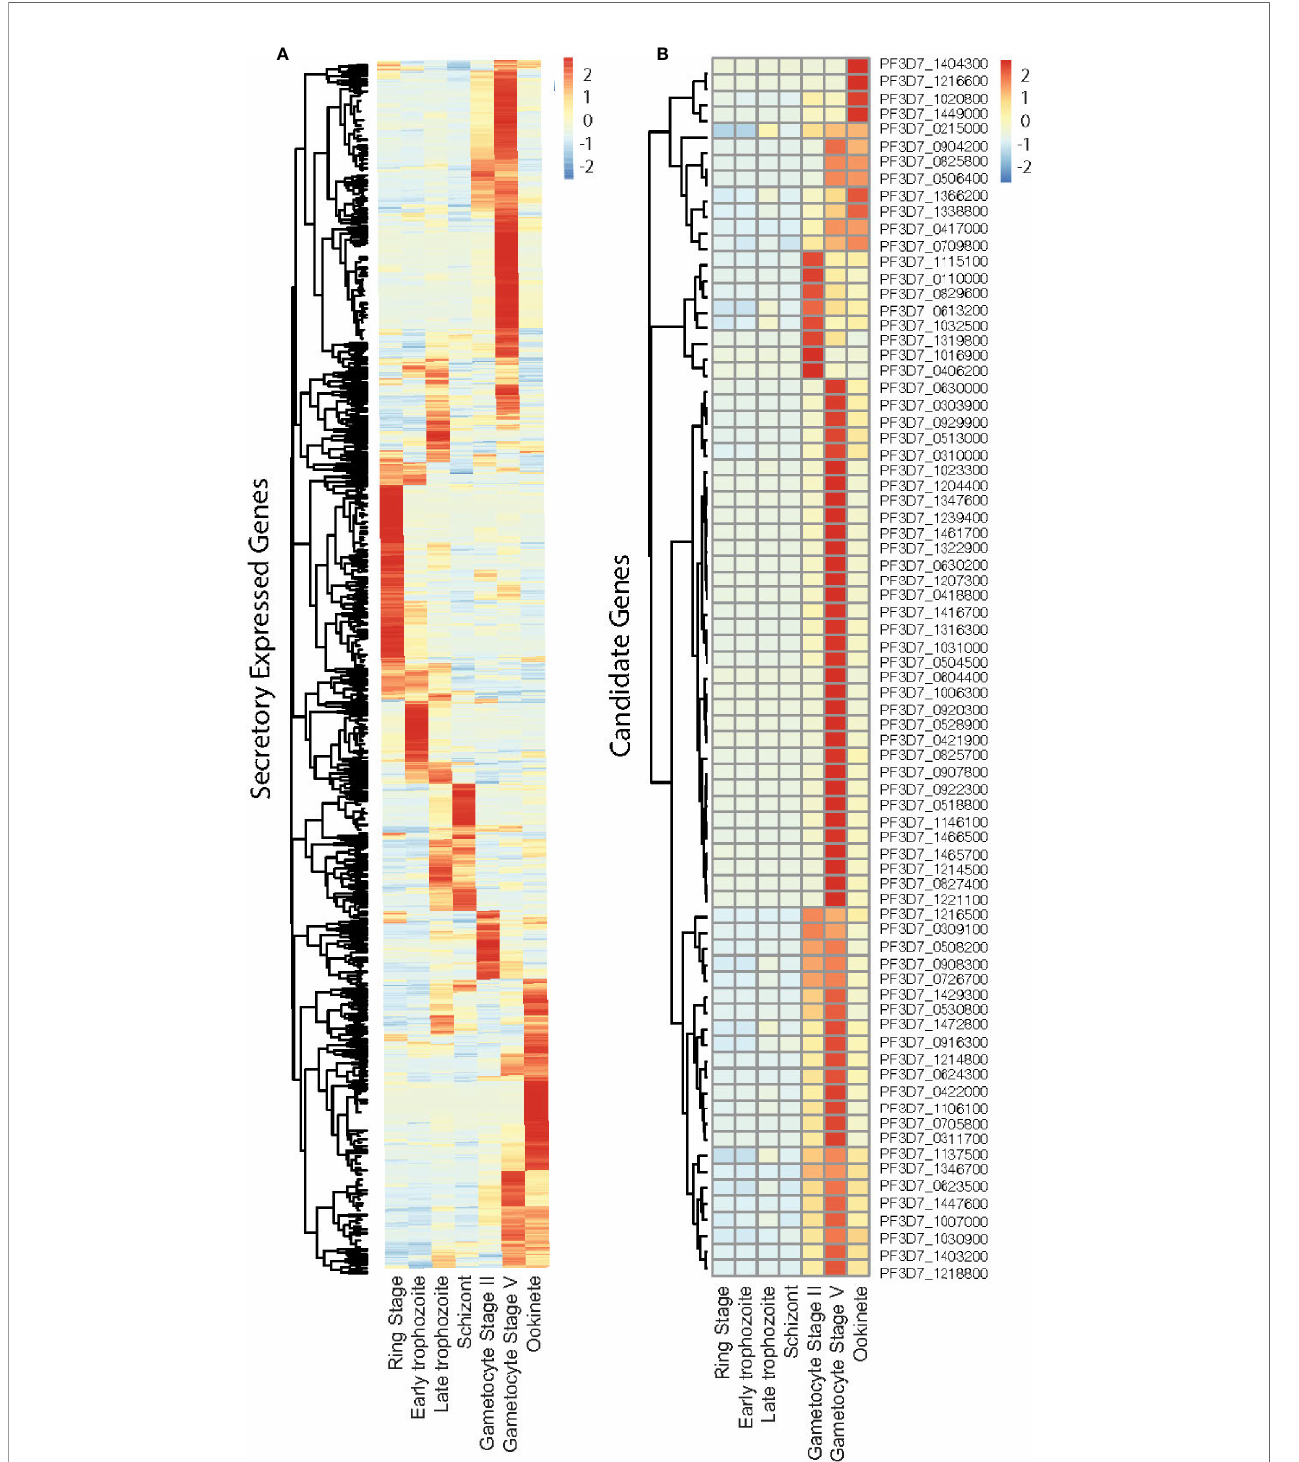
FIGURE 1 | Expression pro fi le of the Plasmodium falciparum genes containing signal peptide at different developmental stages. (A) The expression pro fi les of 1,079 parasitic proteins containing signal peptides using RNA-seq data (Lopez-Barragan et al., 2011). (B) The expression pro fi les of candidate